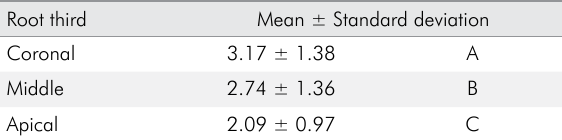
Table 2. Push-out bond strength means (in MPa) of the filling material to root dentin at the different root thirds.